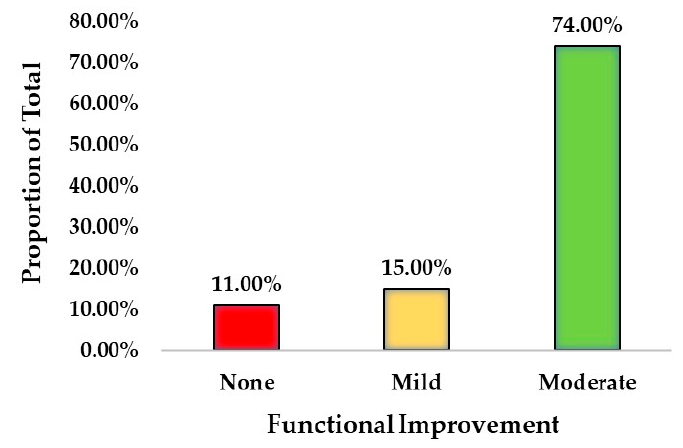
Figure 2. Functional improvement with H-Wave treatment.